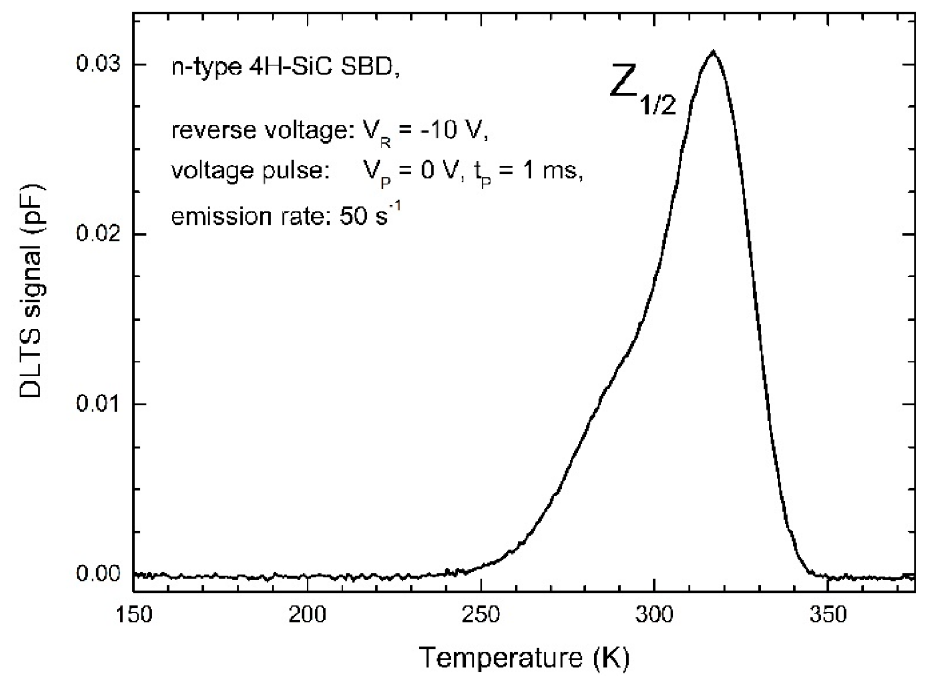
Figure 5. Typical DLTS spectrum for as prepared n-type 4H-SiC SBD. Data reproduced from Ref. [9].